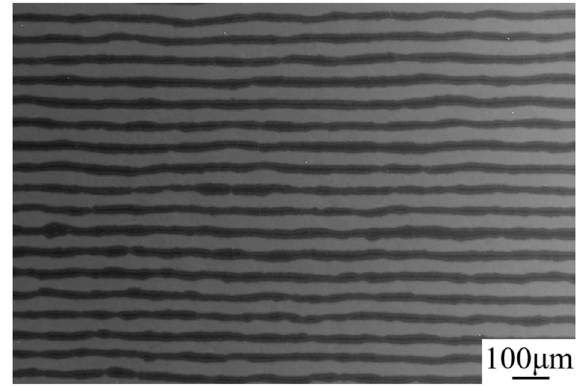
Figure 4. Typical microstructure of the as-received specimen